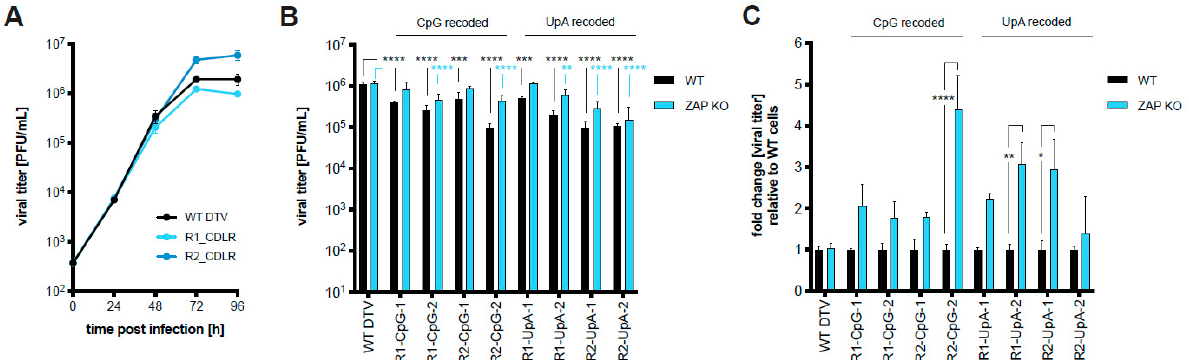
Figure 2. Replication kinetics of CpG- and UpA-recoded DTV constructs. ( A ) Huh-7.5 cells were infected with WT DTV and CDLR recoded control viruses (MOI = 0.01 PFU/cell). Supernatants were harvested daily for 4 d and infectious virus was titered by plaque assay. ( B ) WT and ZAP KO HEK-293T cells were infected (MOI = 1 PFU/cell) with WT and CpG or UpA recoded DTV. Supernatants were collected after 24 h and infectious virus was titered by plaque assay. **, p < 0.005; ***, p < 0.0005; ****, p < 0.0001, two-way ANOVA with Dunnett’s multiple comparison test. ( C ) For each virus, titers from ( B ) were normalized to that of the WT HEK-293T cells to indicate the fold change in virus titers produced in ZAP KO compared to WT cells. *, p < 0.05; **, p < 0.01; ****, p < 0.0001, two-way ANOVA with Šidák’s multiple comparisons test. ( A – C ) Mean titers of triplicate samples are plotted; error bars indicate the SD.